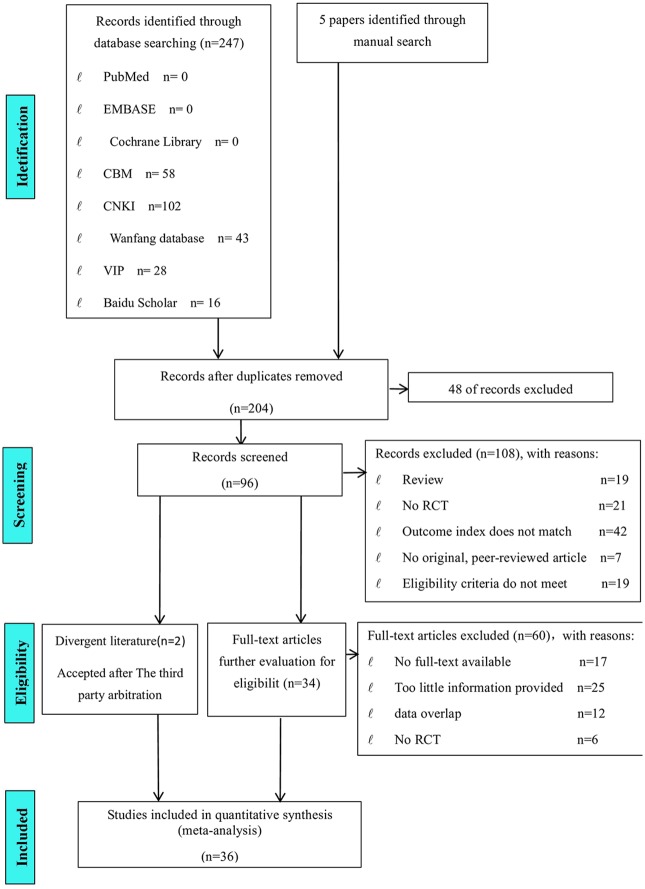
Preferred reporting items for systematic reviews and meta-analyses flowchart depicting the study identification, screening, eligibility and inclusion process.